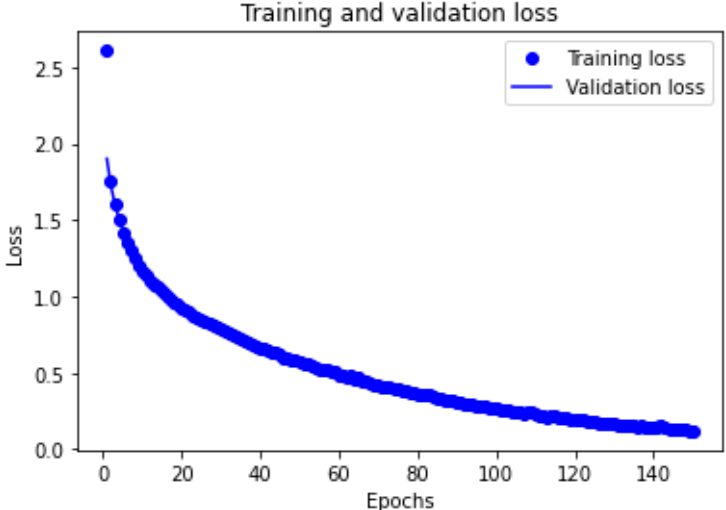
Figure 4. Training and Validation Loss of Deep Learning Neural Network.